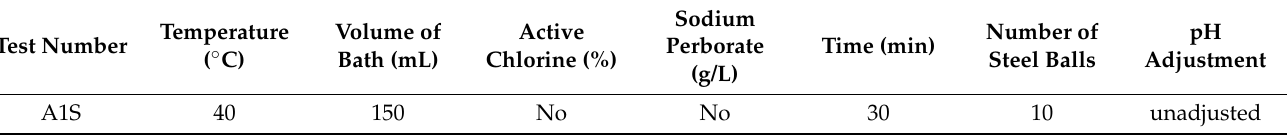
Table 2. The A1S test conditions according to UNE-EN ISO